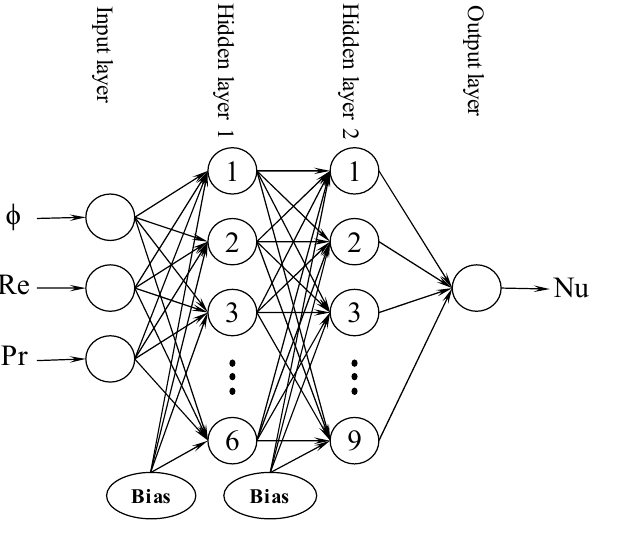
Fig. 3. Architecture of the ANN.